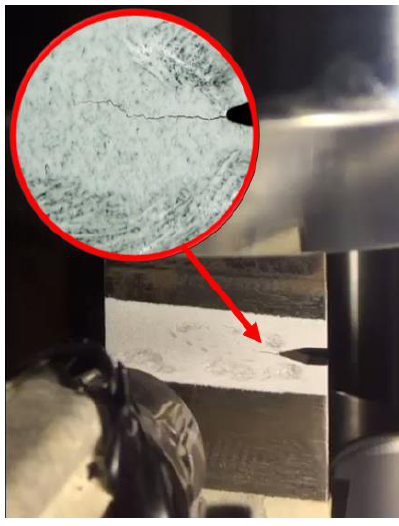
Figure 4: Crack investigation during fatigue crack growth rate test.